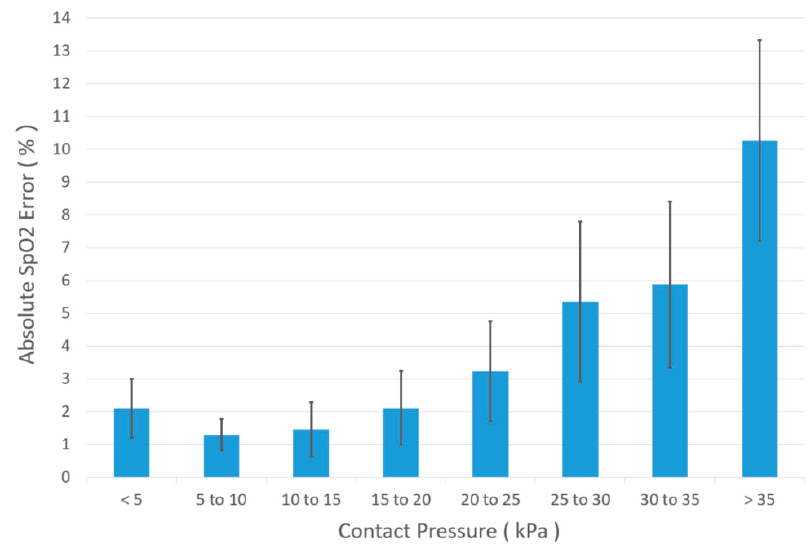
Figure 8. Effect of contact pressure on S p O 2 error between optical fibre sensor and a commercial pulse oximeter. When the contact pressure is higher than 25 kPa, the S p O 2 error is >10%. When the contact pressure is lower than 15 kPa, the S p O 2 error is lower than 2%. The S p O 2 error reached the lowest value while the contact pressure is in the range from 5 to 15 kPa.